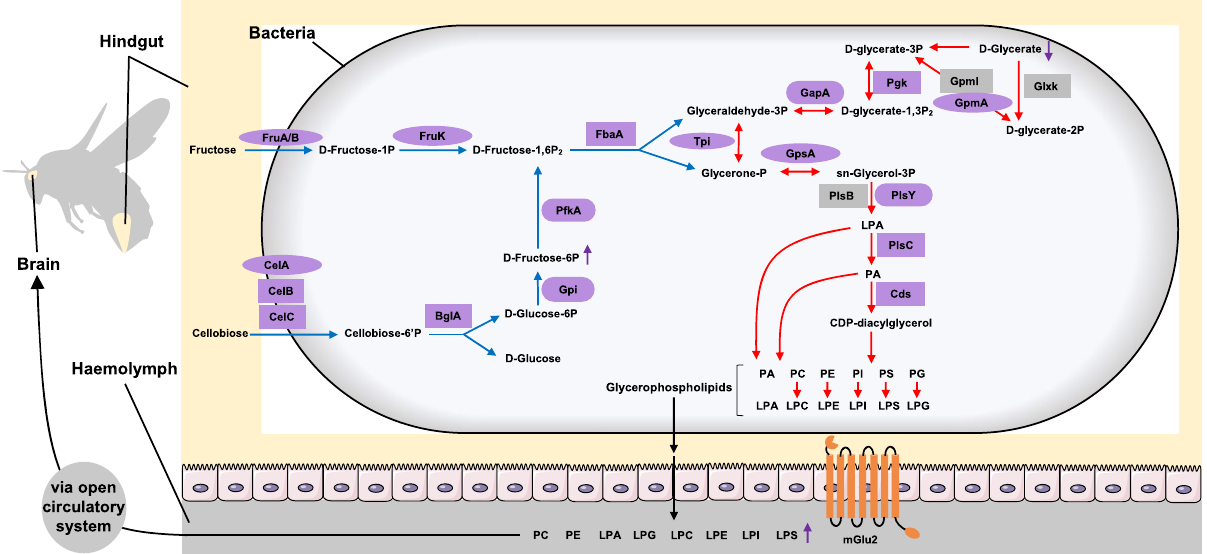
Fig. 4 Proposed pathway between intestinal glycerophospholipid production and memory enhancement. Based on our metagenomic and metabolomic analyses, we suggest that increased levels of L. apis (and other Firm-5 species which similarly contain many genes for the PTS sugar transport pathway) will cause increased sugar metabolism, which will lead to the production of more glycerophospholipids. These glycerophospholipids are then transported into the hindgut and are rapidly secreted into the haemolymph (perhaps helped by an increase in mGlu2 receptors). They are transported to the brain via the bee ’ s open circulatory system, with attached metabolites, leading to improved structure and function of neural and synaptic membranes, thereby promoting better memory. Purple shapes: genes that positively correlated with long-term memory; rectangles: genes found in all three analyses (analyses based on genes mapped to the whole gut microbiota, Firm-5 and L. apis ); Ovals: genes found in whole gut microbiota and Firm-5 analyses; Rounded rectangles: remaining memory-correlated genes; Grey shapes: genes which did not correlate with long-term memory; Blue arrows: sugar metabolism; Red arrows: glycerophospholipid metabolism; Purple arrows: the increase or decrease of metabolites after L. apis